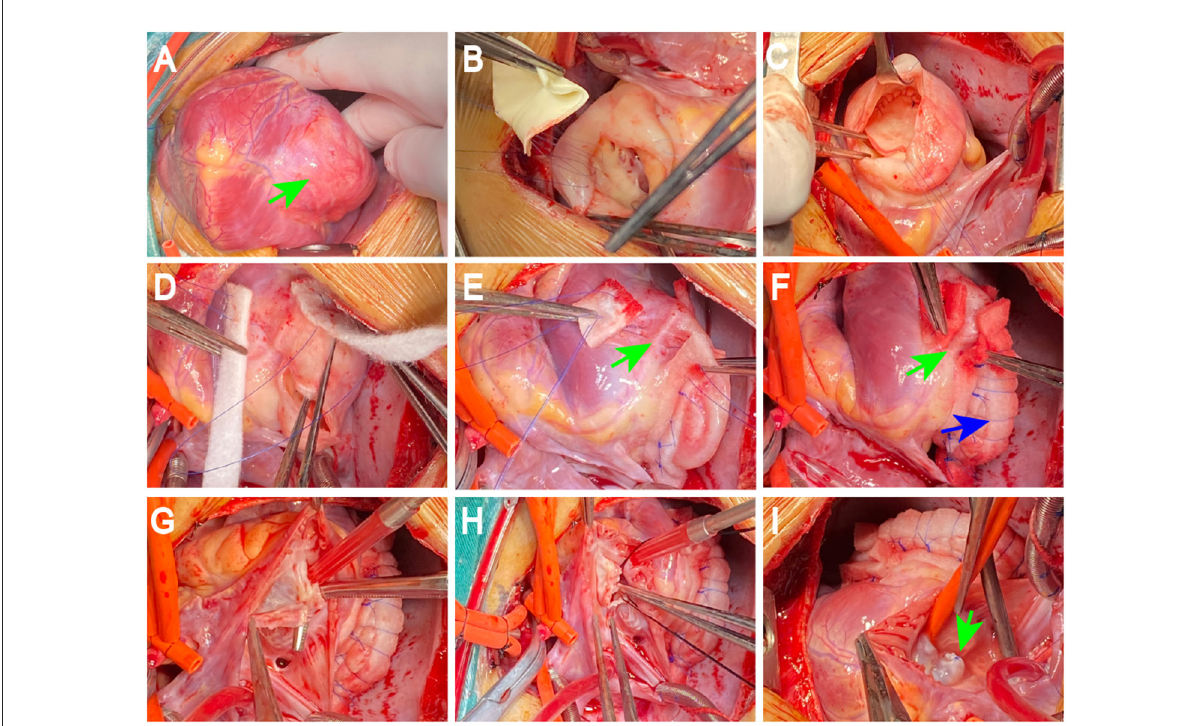
FIGURE2 Surgical procedure. The aneurysmal portion of the left ventricle was thinned and was significantly expansive, the aneurysm well has sharply defined edges (blue arrow; A ). The bovine pericardium was used to close the aneurysm’s neck after being surgically incised (B,C) . Felt pads were used to close the epicardium over the patch (D) , resulting in a detour formed around the posterior descending artery (PDA) and PDA was well protected in a “sandwich” (green arrow; E,F ). The third strip of the felt pad reinforced the “sandwich” structure (blue arrow; F ). 5.0 Prolene suture lines were used to sew the rupture, valvuloplasty of the anterior tricuspid leaflet was performed (G,H) . Testing with saline solution injection showed no tricuspid regurgitation (green arrow; I ). PDA: the posterior descending